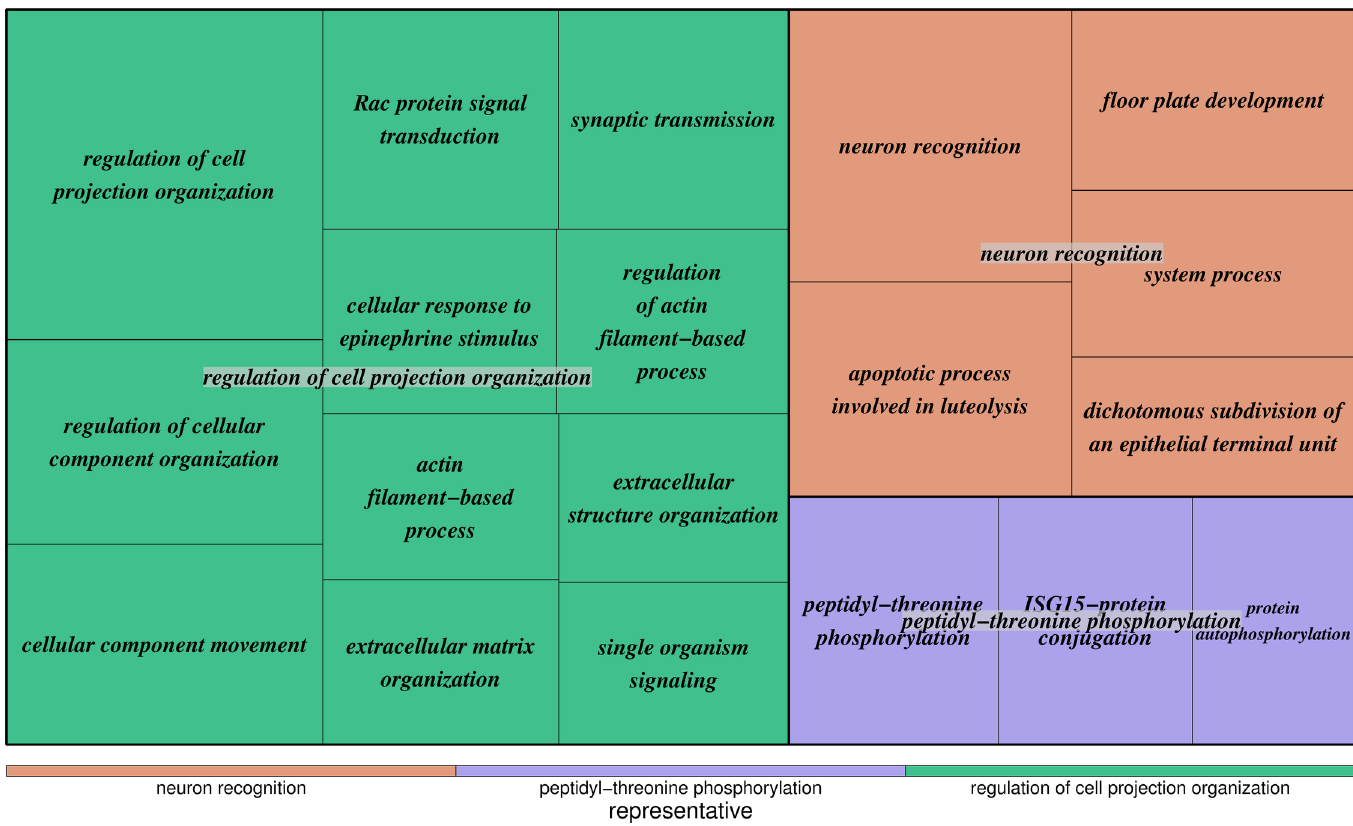
Fig 4. Top three gene ontology enrichment groups associated with susceptibility of CAA formation in KD. After gene ontology (GO) enrichment analysis, 162 over-represented GO terms were obtained and further summarized into GO clusters. The top three significant clusters were regulation of cell projection organization ( P = 2.22 × 10 − 6 ), neuron recognition ( P = 6.72 × 10 − 5 ), and peptidyl-threonine phosphorylation ( P = 1.53 × 10 − 3 ).